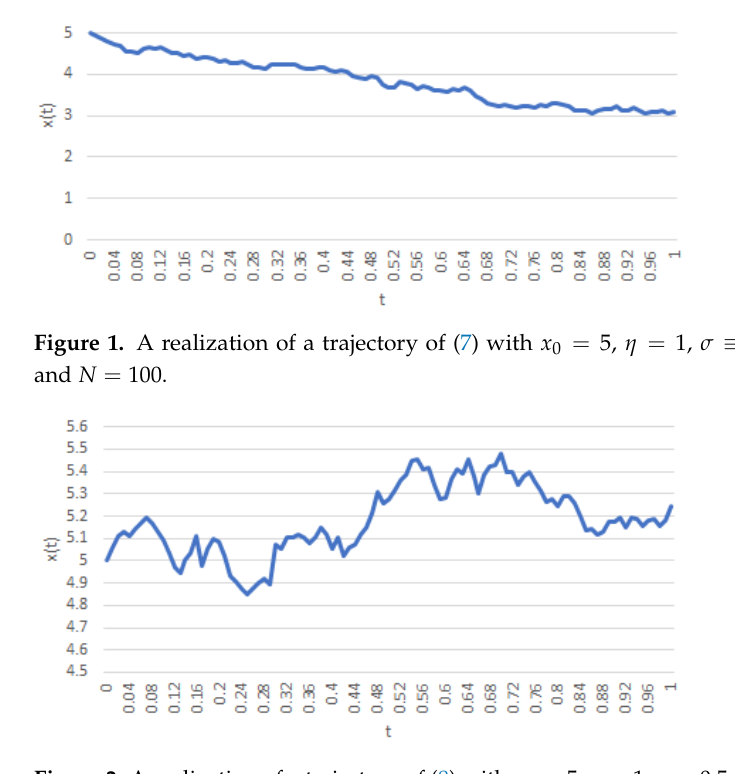
Figure 2. A realization of a trajectory of (8) with x 0 = 5, η = 1, σ ≡ 0.5, µ = 5, T = 1, and N =